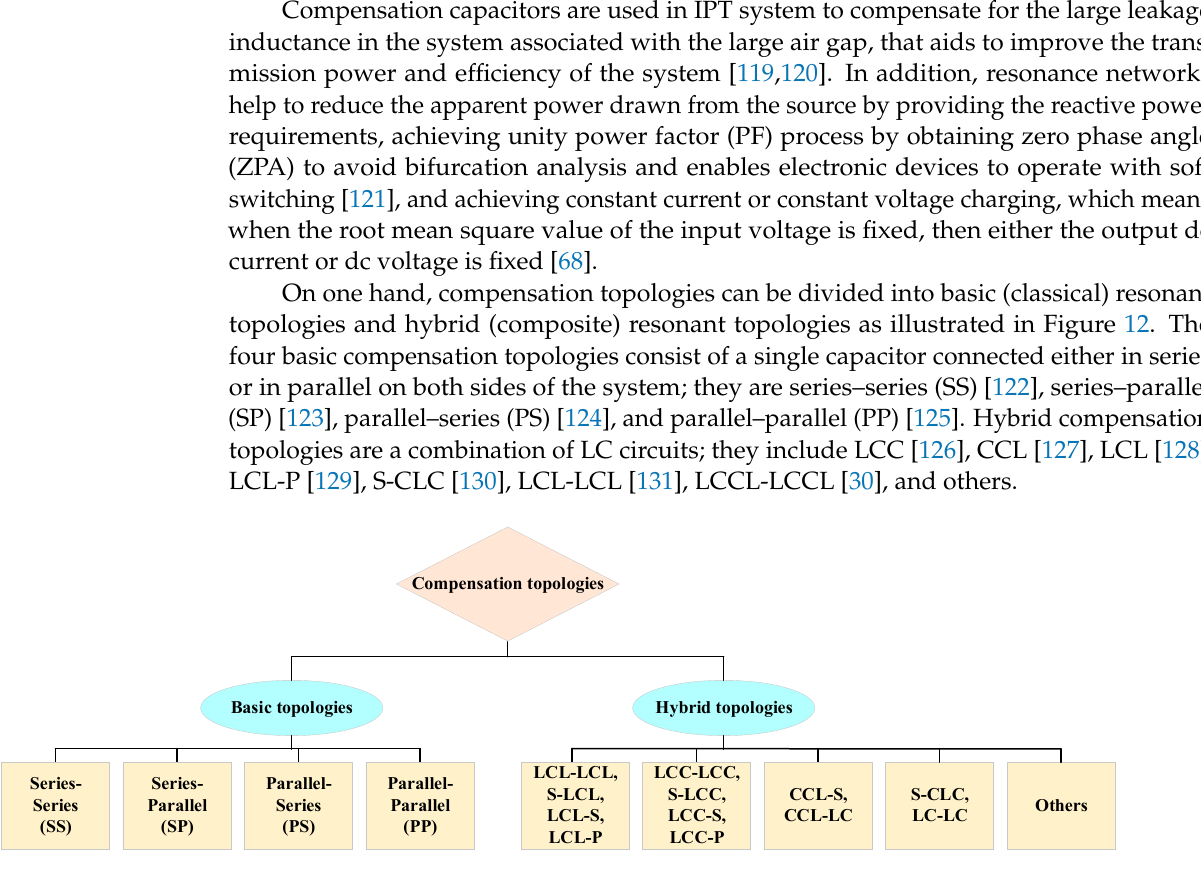
Figure 12. Classification of compensation topologies.